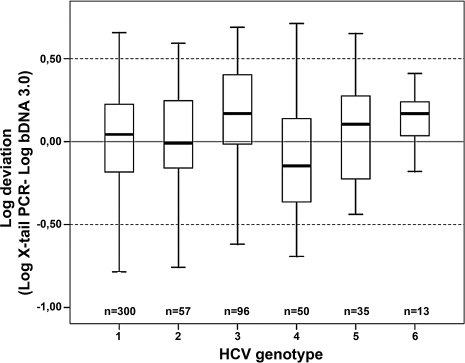
Quantitative Deviations between X-Tail–Based and bDNA Viral Loads, per Genotype (y-Axis)Genotypes are indicated below the x-axis, the number of samples tested per genotype (n) above the x-axis. Each box shows the median, interquartile range (box length, containing 50% of data) and whiskers show extreme values (there were no statistical outliers). Deviations between X-tail RT-PCR and bDNA [log10 X-tail RT-PCR − log10 bDNA] were genotype 1, 0.00/0.31 (mean/SD); genotype 2, 0.01/0.33; genotype 3, 0.17/0.32; genotype 4, −0.09/0.37; genotype 5, 0.07/0.31; and genotype 6, 0.12/0.19.